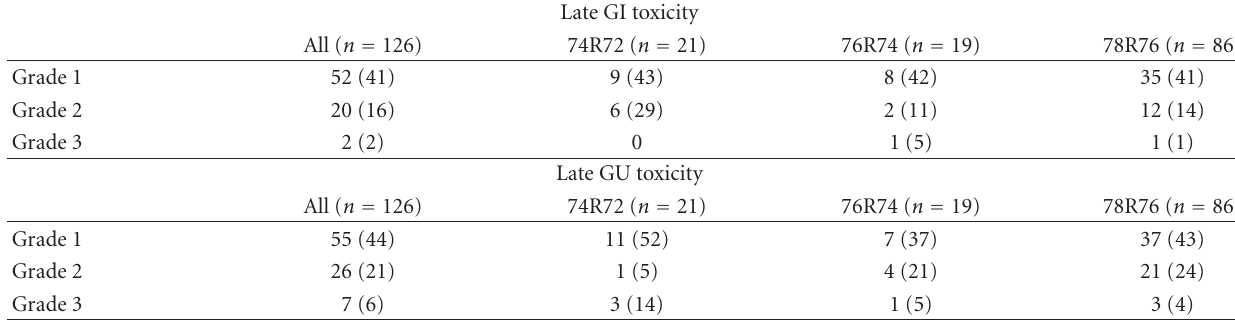
Table 4: Late gastrointestinal and genitourinary toxicity for all patients and according to prescription